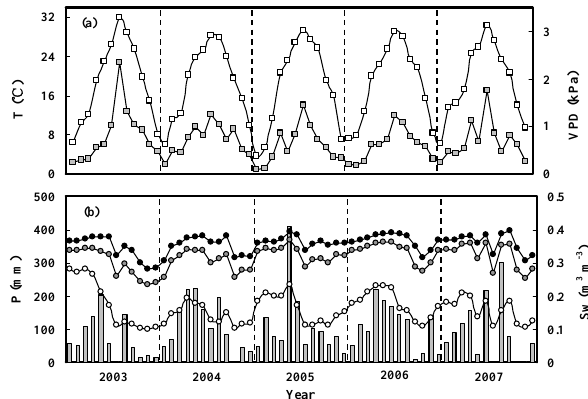
Fig. 2. Seasonal and interannual variations of monthly (a) air tem- perature ( T , blank squares) and vapour pressure deficit (VPD, gray squares) at the height of the eddy covariance system, and (b) pre- cipitation ( P , gray bars) and soil water contents (Sw, 5cm: blank circles; 20cm: gray circles; 50cm: black circles) from 2003 to 2007 at Qianyanzhou